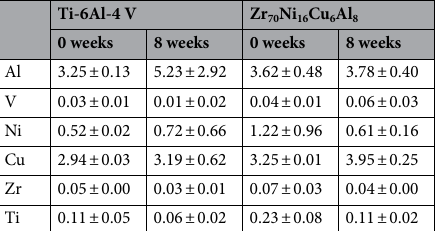
Table 3. Measurement of metal concentration in beagle dog blood (μg/g). Data are expressed as mean ±